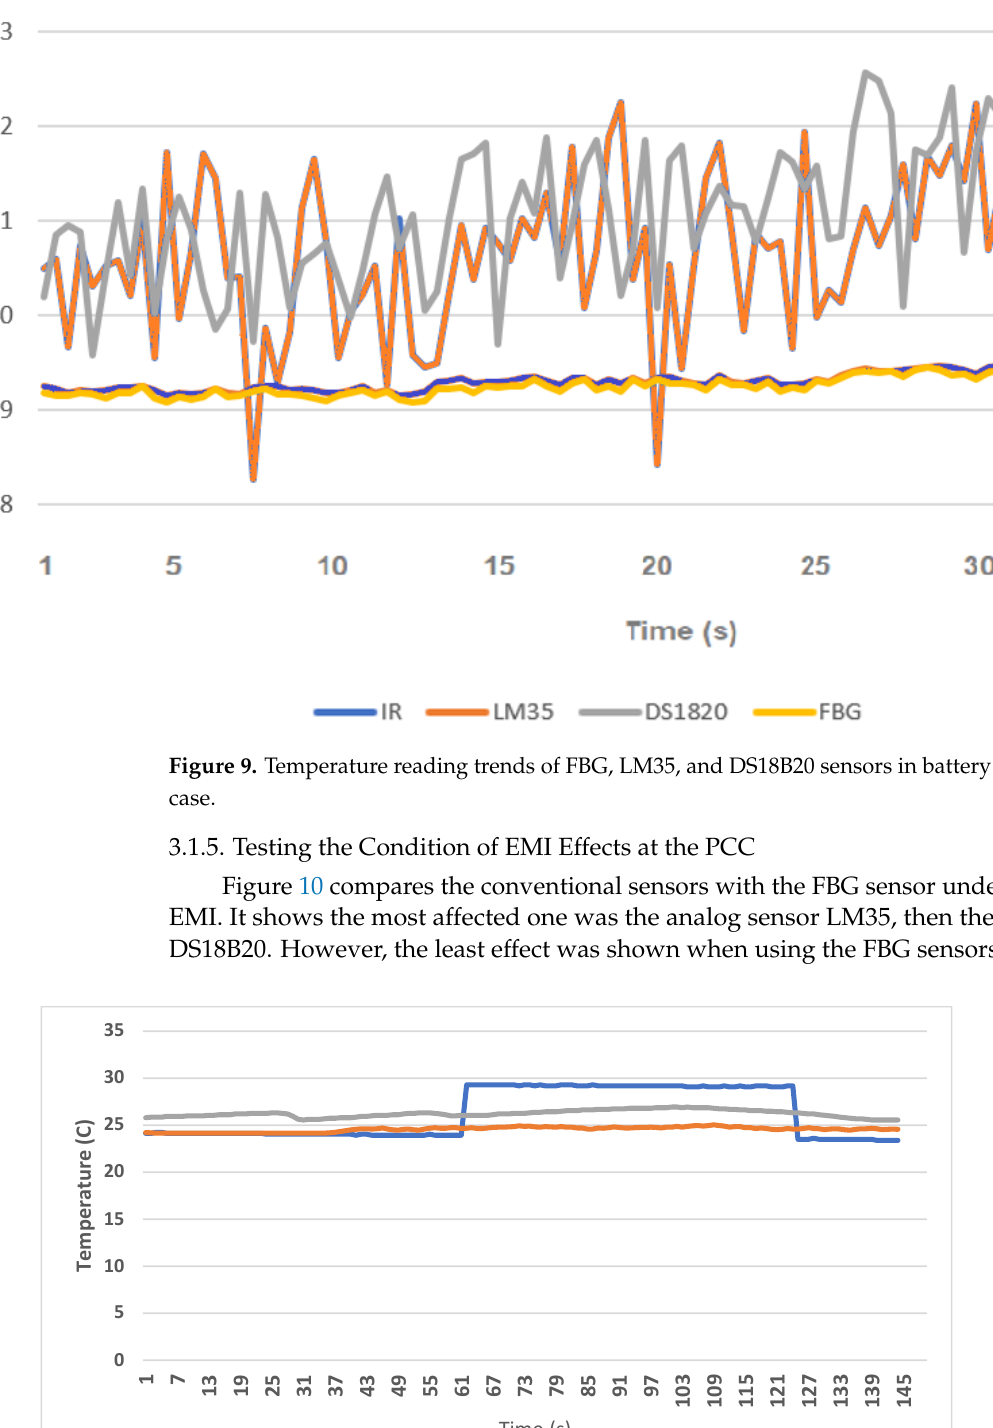
Figure 10. EMI effects on the FBG, LM35, and DS18B20 sensors.